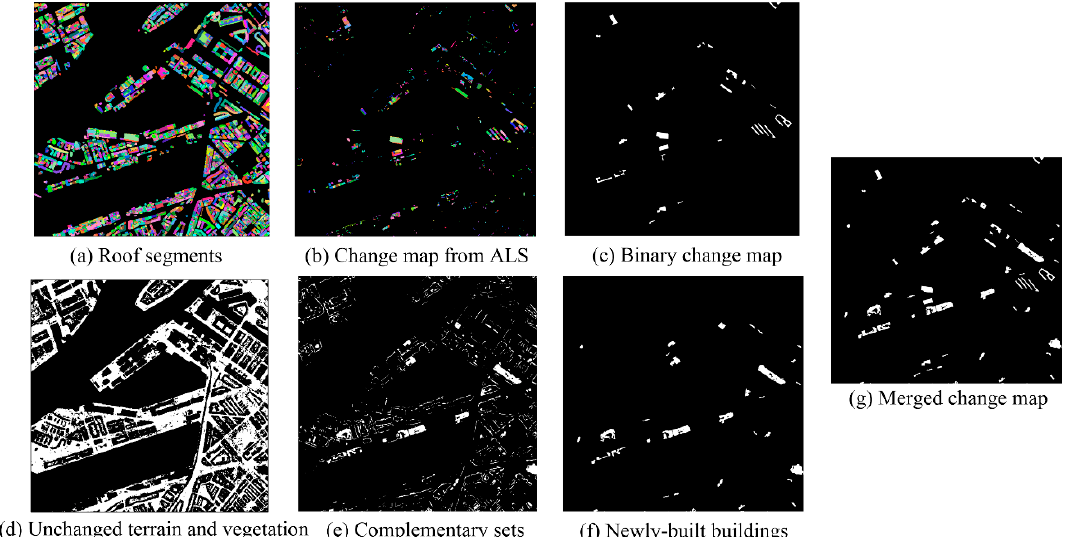
Figure 7. Intermediate products for Rotterdam data.